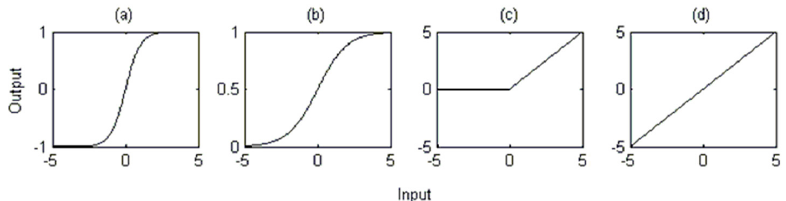
Figure 5. Neuron Transfer Functions: ( a ) ‘Tanh’ ( b ) ‘Sigmoid’ ( c ) ‘ReLU’ and ( d ) ‘Linear’. For error estimation, the mean square percentage error (MSPE) was used: